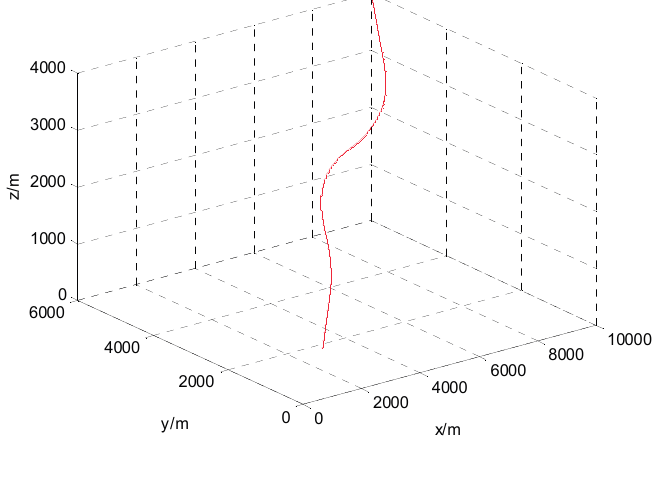
Figure 3. Trajectory of